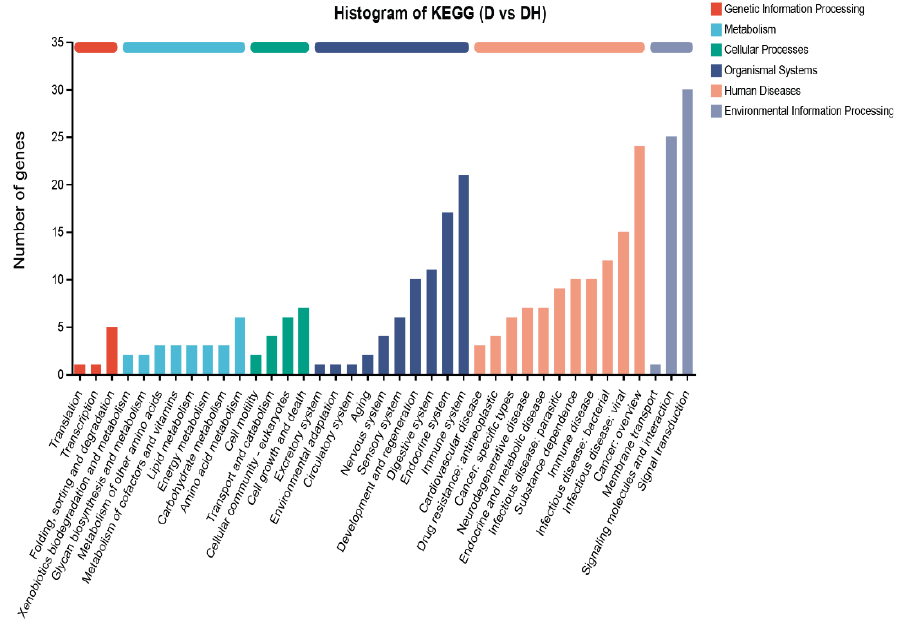
Figure 5. KEGG enrichment analysis with the differentially expressed genes of groups D and DH.